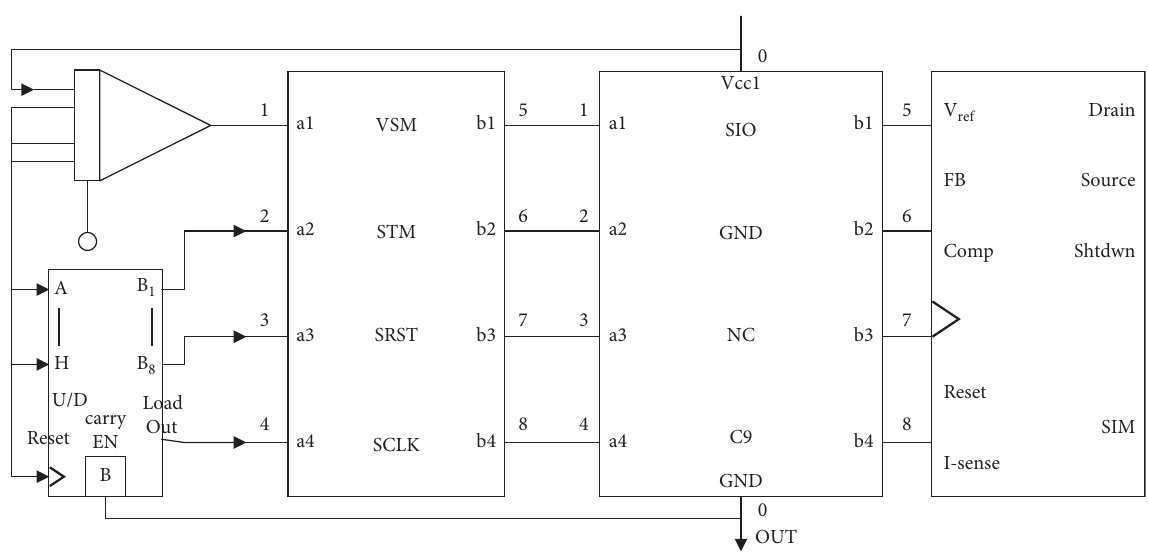
Figure 2: SIM card module.